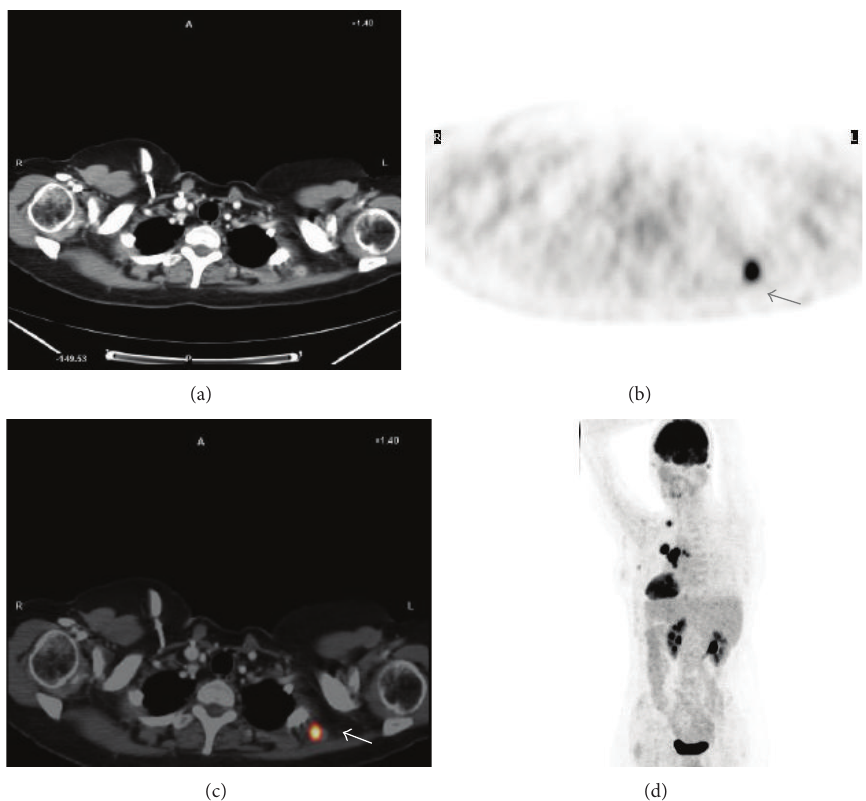
Figure 3: Images for a 55-year-old woman with stage IIIB NSCLC (adenocarcinoma). (a) CT imaging failed to detect any metastatic tumor. (b) PET image showing intense, nonlocalised uptake of 18 F-FDG. (c) PET/CT image showing 18 F-FDG uptake in a metastatic tumor in the trapezius muscle. Histological confirmation of the metastatic nature of the lesion. (d) Coronal whole-body PET image showing primary and metastatic lesions (arrowheads). PET = positron emission tomography; CT = computed tomography.